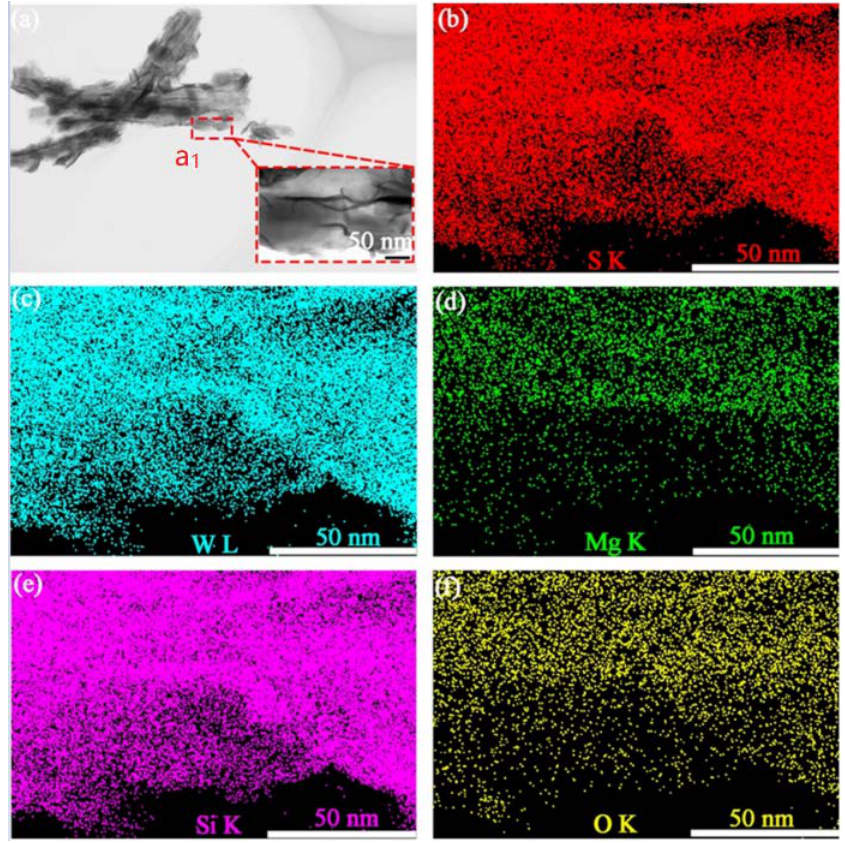
Figure 3. EDS mapping analysis of element distribution ( b – f ) in marked area (red rectangle in ( a )) for the WS 2 /Sep nanocomposite: S ( b ), W ( c ), Mg ( d ), Si ( e ), and O ( f ).